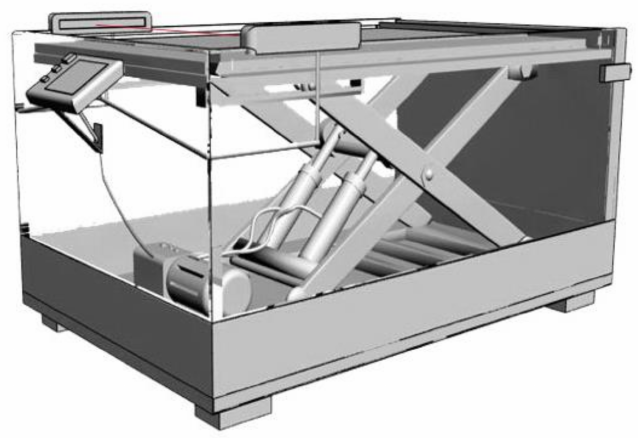
Figure 10. The bend-free boards rack, equipped with infrared positioning device and hydraulic actuator.